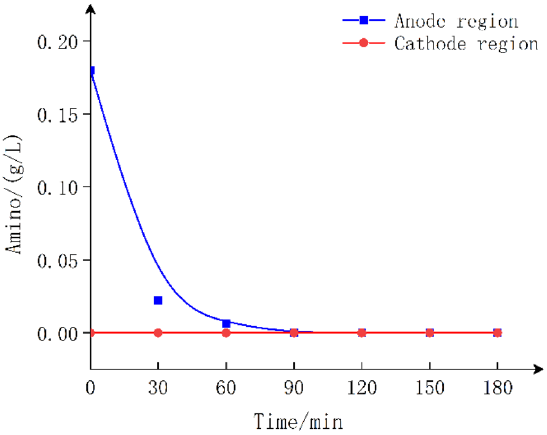
Figure 5. GlyGl migration vs time in anode region under anionic membrane.